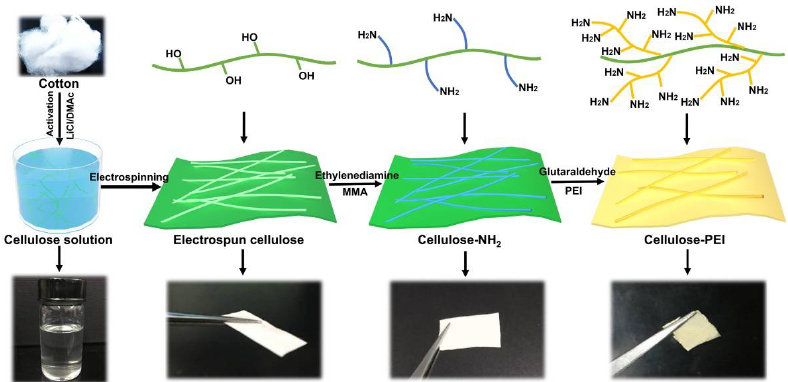
Figure 1. Schematic for the preparation process of